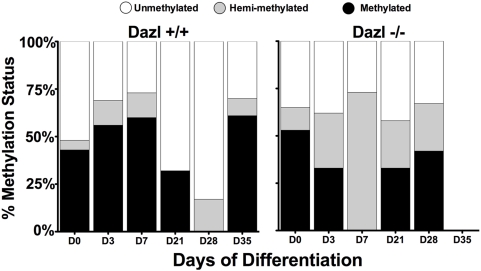

Dazl is required for Erasure and Re-establishment of H19 DMR Imprints.Results of bisulphite sequencing on GFP-positive germ cells isolated by FACS, displaying an average percent methylation status (y-axis) and days of differentiation on the x-axis. Average values are from 40 clones per datapoint (20 clones per individual sample, 2 replicates for each genotype/timepoint).